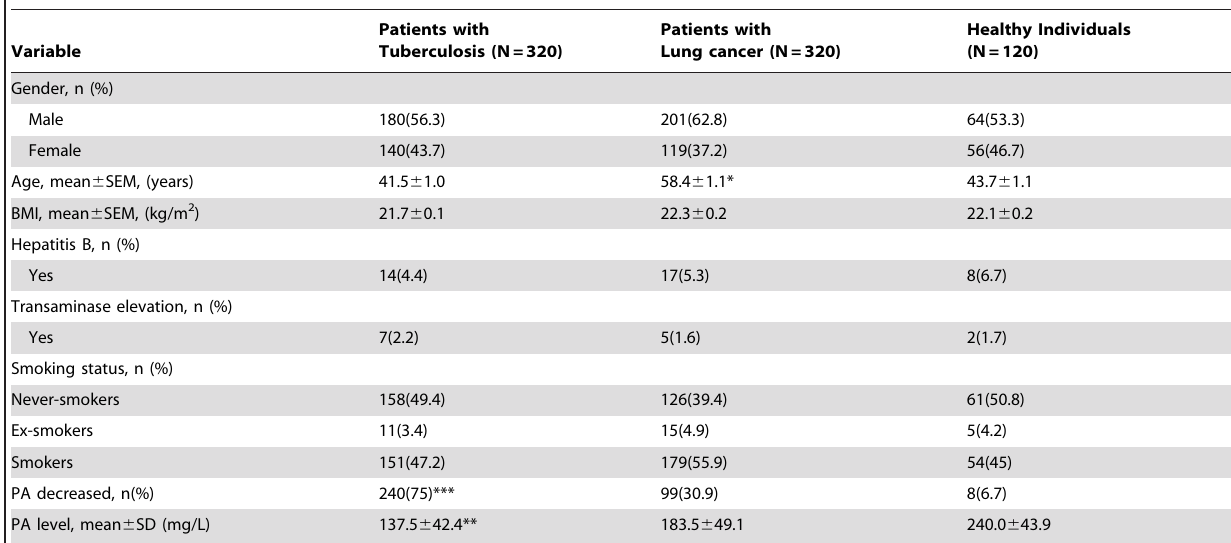
Table 1. Clinical Characteristics of the Study Population.